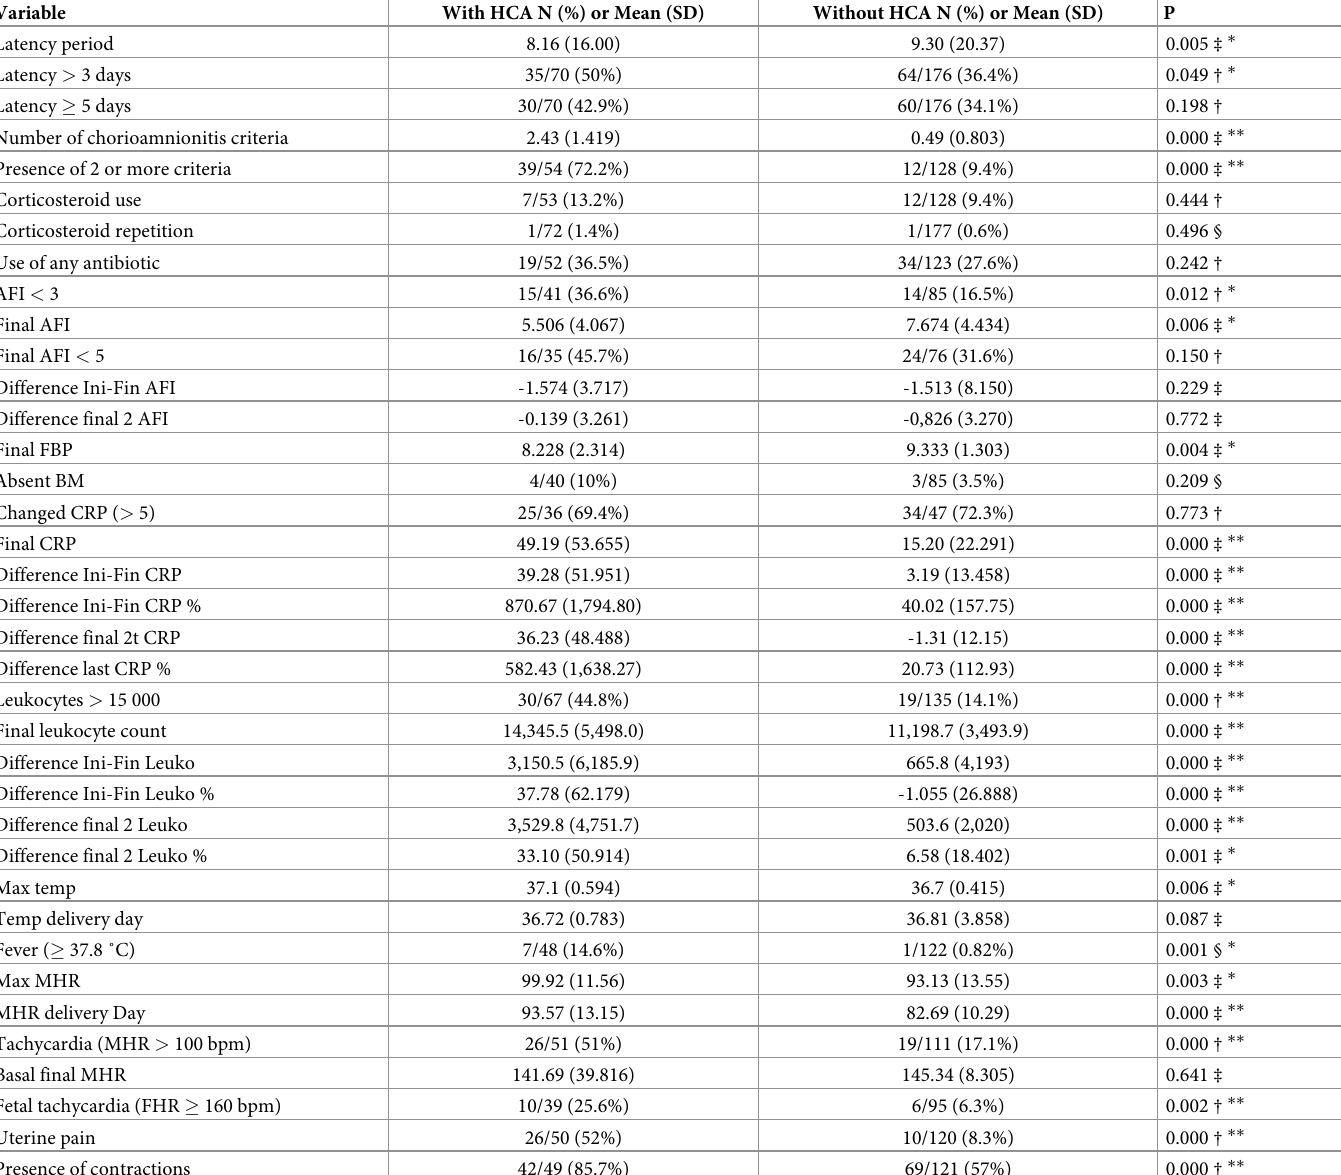
Table 2. Characteristics of the clinical and laboratory progression of 295 pregnant women with PPROM according to the presence or absence of Histological Chorioamnionitis. Variable With HCA N (%) or Mean